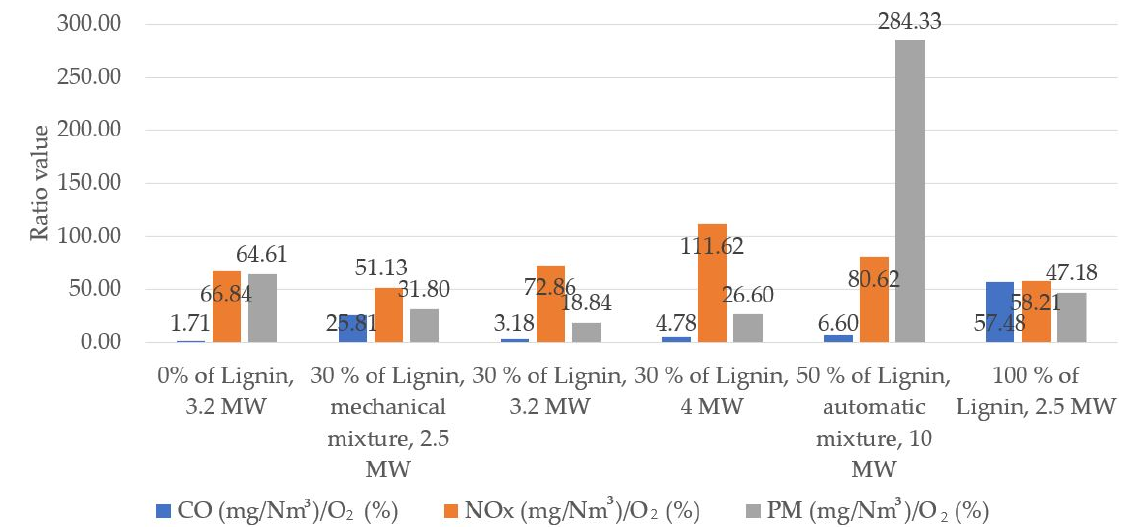
Figure 6. The concentrations of pollutants emitted at different shares of lignin in the burnt fuel under varying powers of the boiler in the combustion mode.